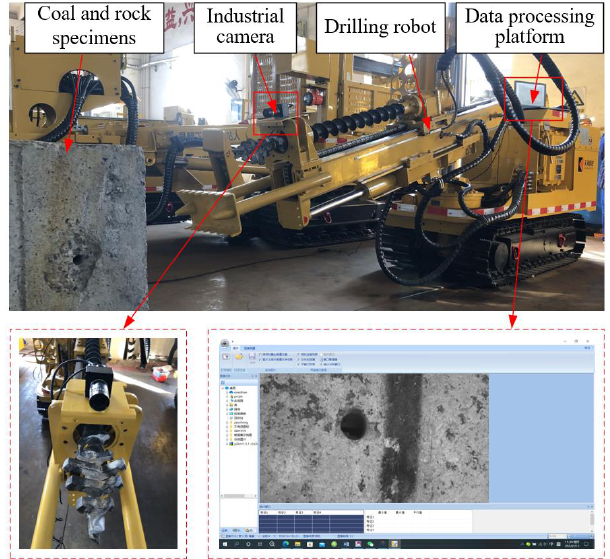
Figure 8. Drilling experiment platform.